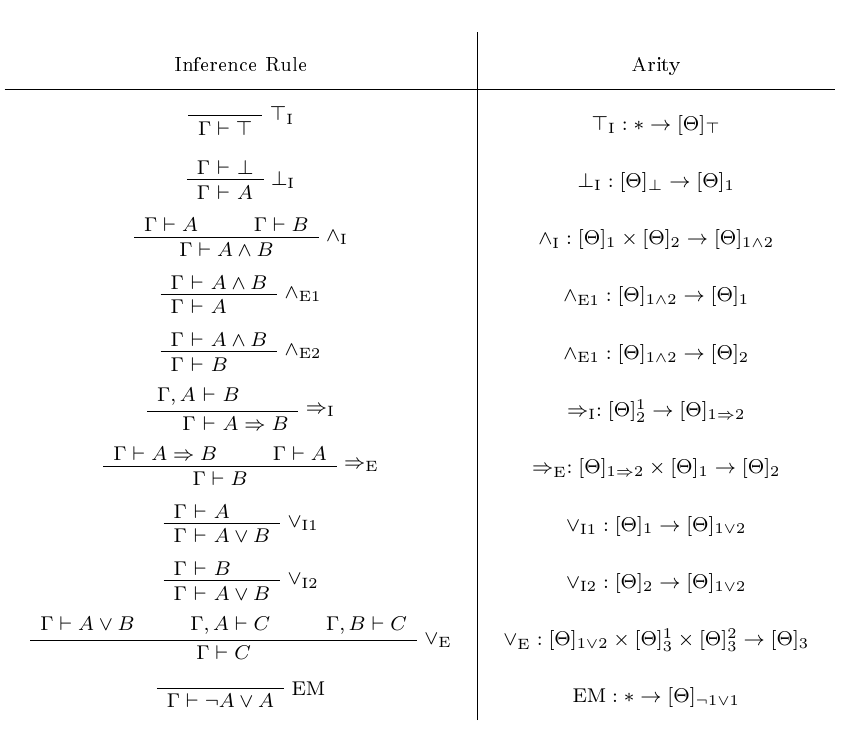
Fig. 3. Inference Rules of CPC and their